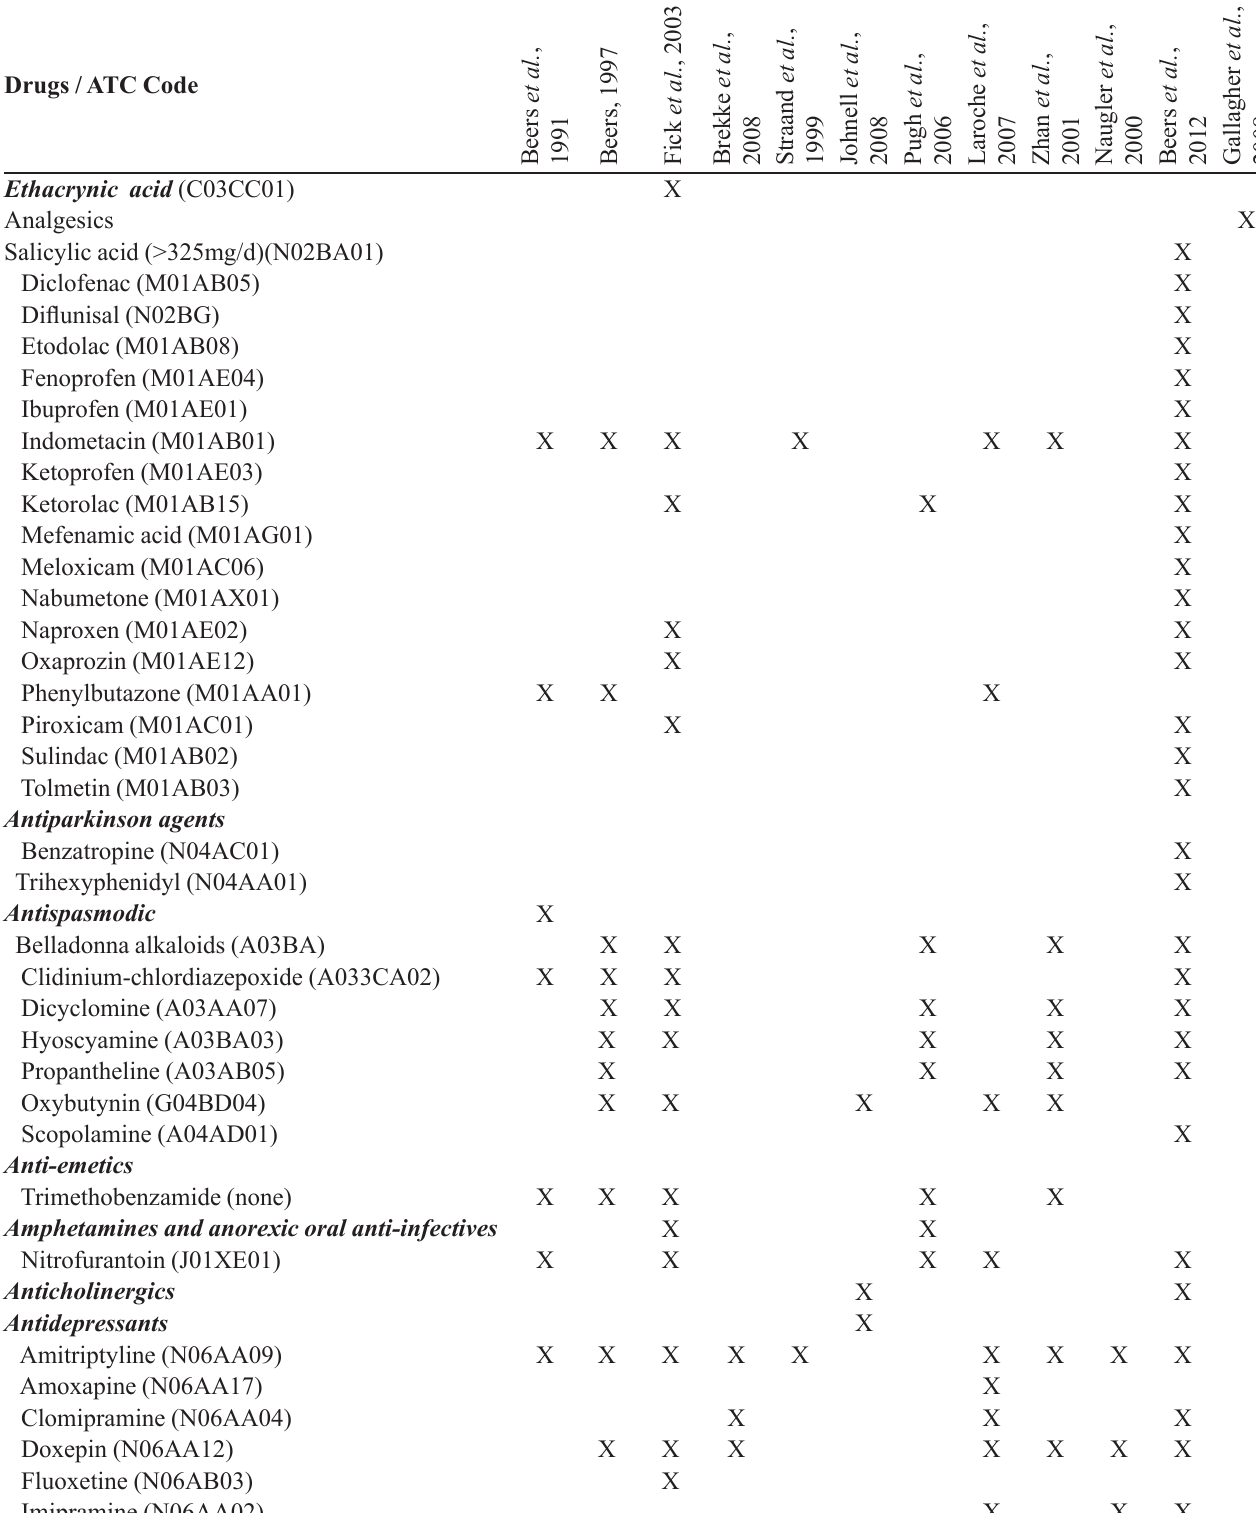
TABLE I - List of potentially inappropriate medications (PIM) for the elderly that should be avoided irrespective of diagnosis or clinical condition, according to the methods identified in PAHO (available in: http://regional.bvsalud.org/php/index.php), Lilacs and Pubmed databases, during the period between February and March 2010